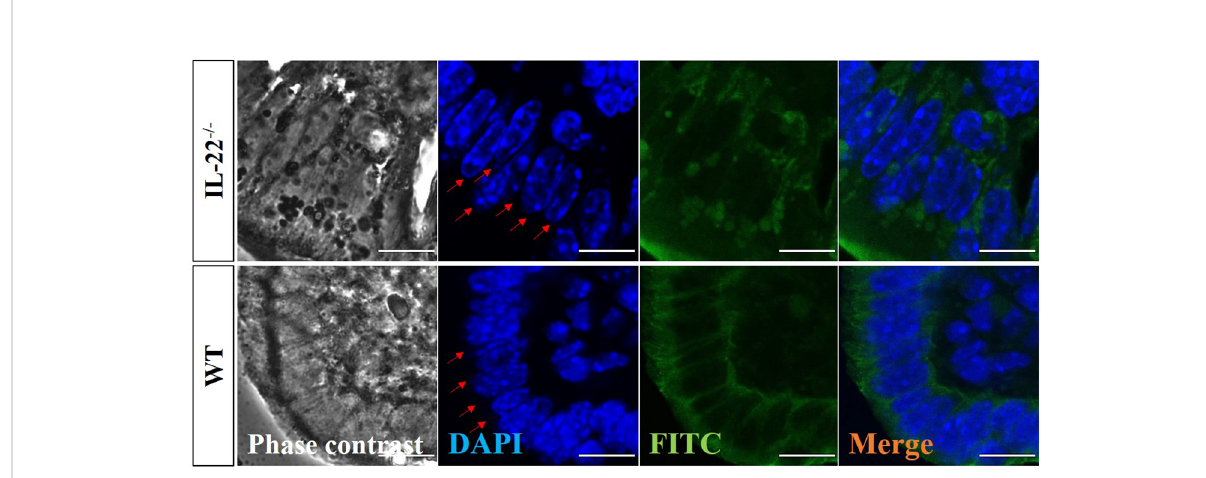
FIGURE 4 Confocal microscopy evaluation of uterine cross-sections. IL-22 − / − , n = 6, and WT, n = 5, mouse uterine samples were harvested 48 h post intraperitoneal LPS injection, frozen fi xed, and processed for IF analysis. Representative images demonstrate phase-contrast (left column), DAPI (middle left column), pan-cytokeratin (middle right column), and merged (right column) images. Red arrows point to the nuclei of luminal epithelium (from the lumen side) to demonstrate the distinct structural organization with epithelial cells forming a uniform lining in WT and the pseudo-strati fi ed appearance with epithelial cell nuclei located at different heights in IL-22 − / − samples. Original magni fi cation 60 × 5; scale bar, 10 µm. WT, wild type; IL-22 − / − , IL-22 knockout; LPS, lipopolysaccharide; IF, immuno fl